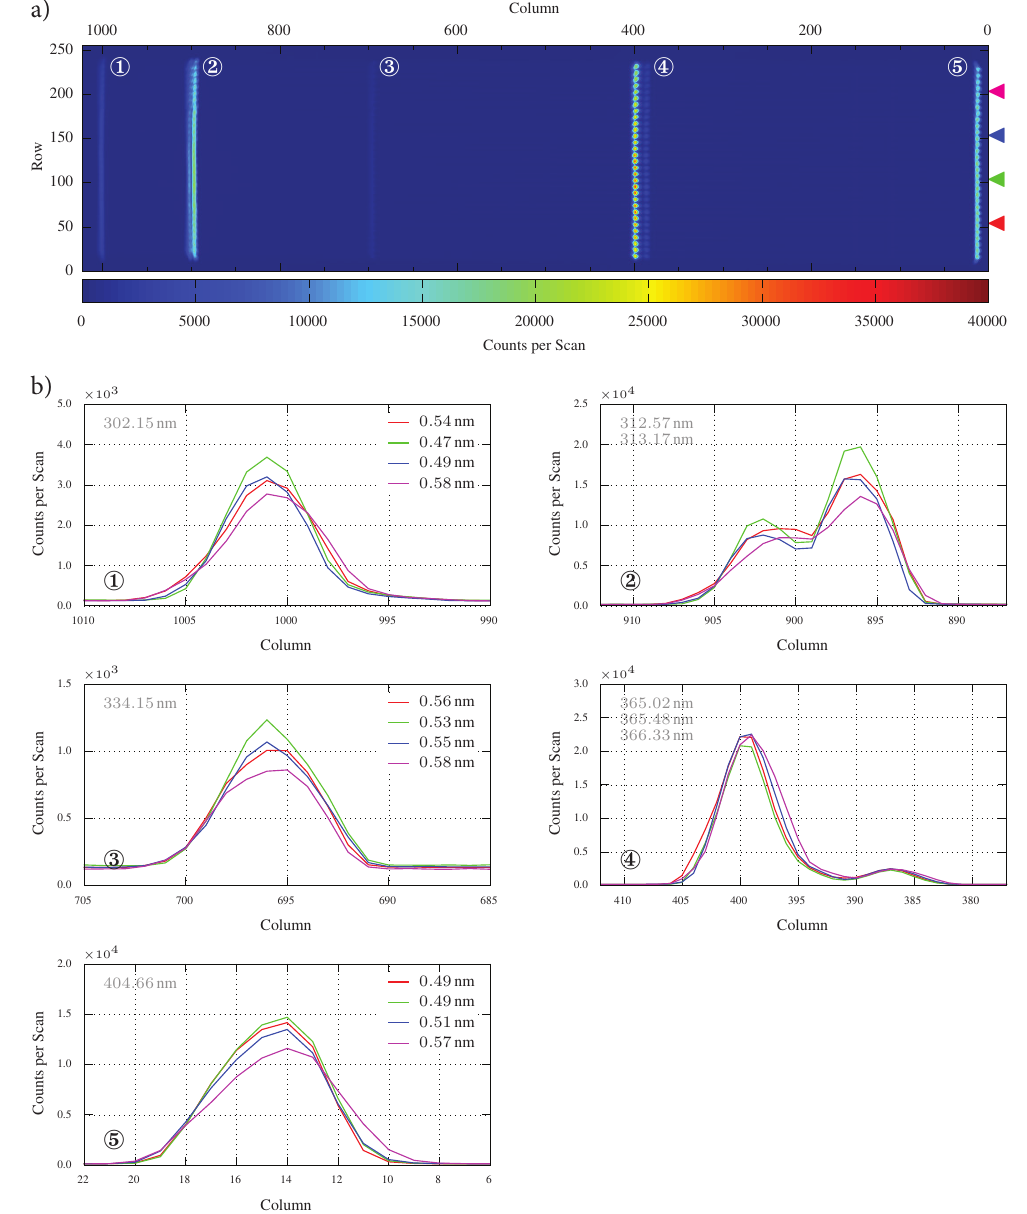
Figure 8. Mercury emission lines between 300 and 407nm (marked with ‹ – (cid:176) in both figures) taken by HAIDI’s detector in full frame readout mode. (a) Intensity plot showing the image of the entrance slit for different emission lines. (b) Mercury lines plotted for different rows of the CCD (see markers in a ). The full width at half maximum (FWHM) of the individual lines is given in the upper right corner of the plots. As can be seen, the peak width increases slightly towards the edges of the CCD, resulting in a lower spectral resolution. This is due to Petzval field curvature (Kidger, 2002). However, the double emission line 312.57nm / 313.17nm can still be resolved for all CCD